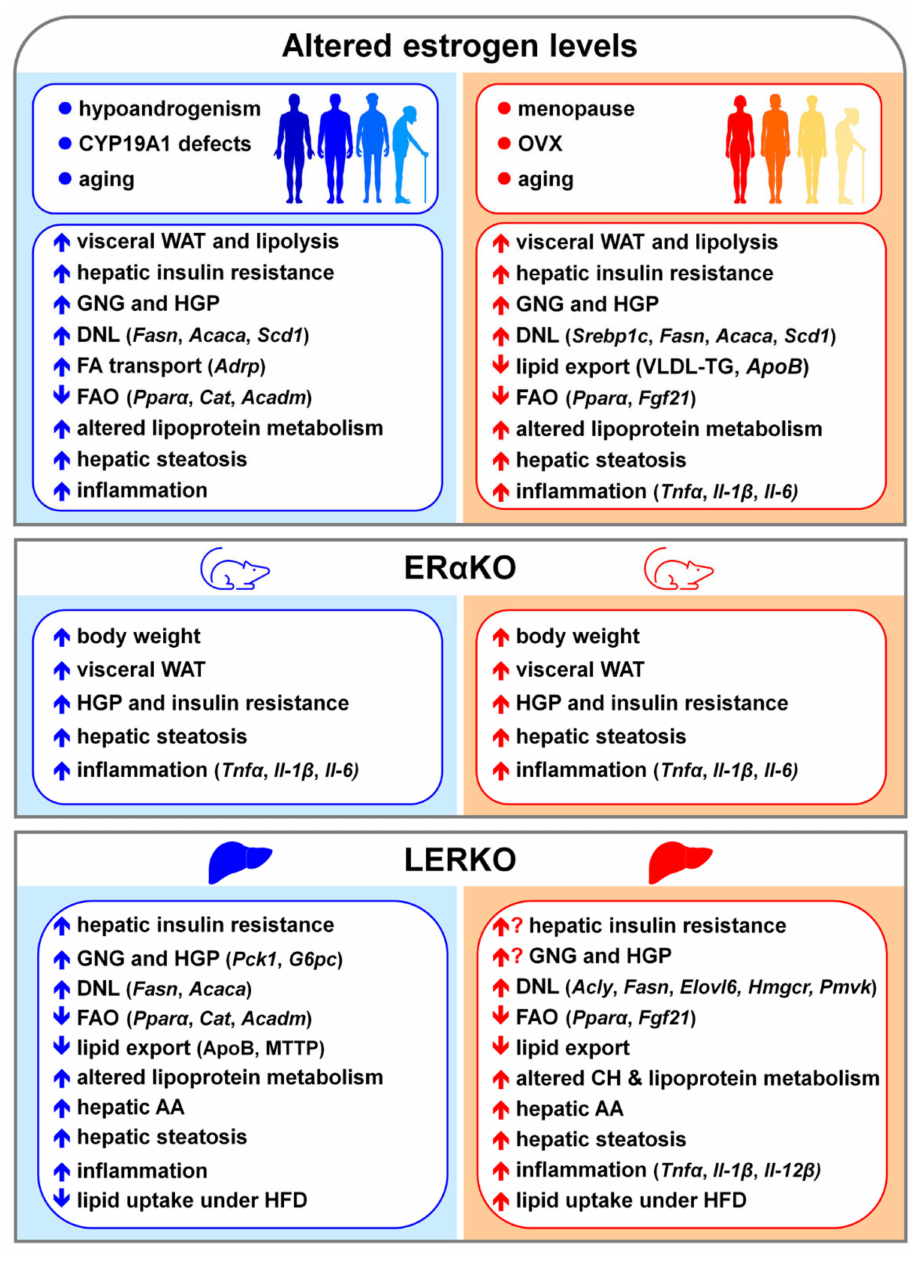
Figure 5. Consequences of altered estrogen signaling in the liver of males (left, in blue) and females (right, in red) favoring NAFLD development and progression. Abbreviations: AA, amino acids; Acaca , acetyl-CoA carboxylase α ; Acadm , acyl-CoA dehydrogenase medium chain; Acly , ATP citrate lyase; Adrp , adipocyte differentiated regulatory protein; ApoB; apolipoprotein B; Cat, catalase; CH, cholesterol; CYP19A1, aromatase; DNL, de novo lipogenesis; Elovl6 , ELOVL fatty acid elongase 6; ER α KO, total ER α knockout mice; FA, fatty acids; FAO, fatty acid oxidation; Fasn , fatty acid synthase; Fgf21 , fibroblast growth factor 21; G6pc , glucose-6-phosphatase; GNG, gluconeogenesis; HFD, high fat diet; HGP, hepatic glucose production; Hmgcr , 3-hydroxy-3-methylglutaryl-CoA reductase; Il- 1 β , interleukin 1 β ; Il-6 , interleukin 6; Il-12 β , interleukin 12 β ; LERKO, liver ER α knockout mice; MTTP; microsomal triglyceride transfer protein; OVX, ovariectomy; Pck1 , phosphoenolpyruvate carboxykinase 1; Pmvk , phosphomevalonate kinase; Ppar α , peroxisome proliferator activated receptor α ; Scd1 , stearoyl-CoA desaturase 1; Srebp1c , sterol regulatory element binding Transcription factor 1; Tnf α , tumor necrosis factor α ; VLDL-TG, very-low density lipoprotein-triglycerides; WAT, white adipose